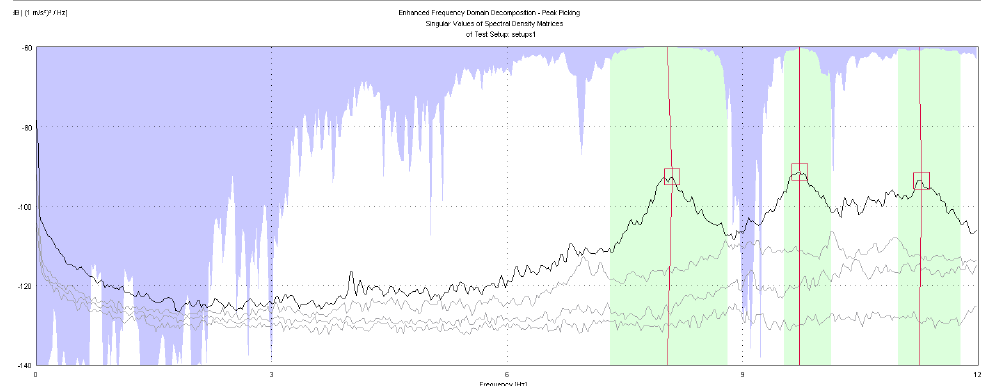
Figure 7. OMA identification with Enhanced Frequency Domain Decomposition (EFDD) method, Test 1.